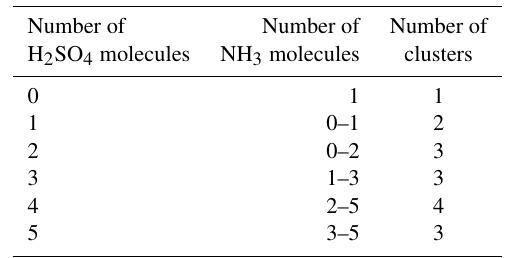
Table 1. Neutral molecular clusters included in the model system (16 in total). The first column indicates the number of sulfuric acid molecules; the second column indicates the number of ammonia in the cluster.